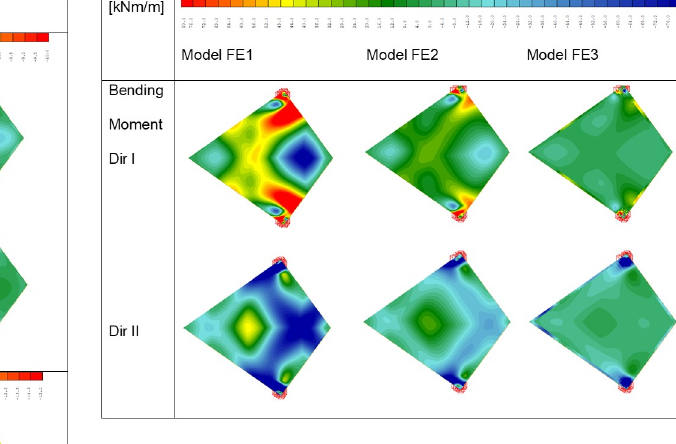
Figure 16: Bending moment in principal directions